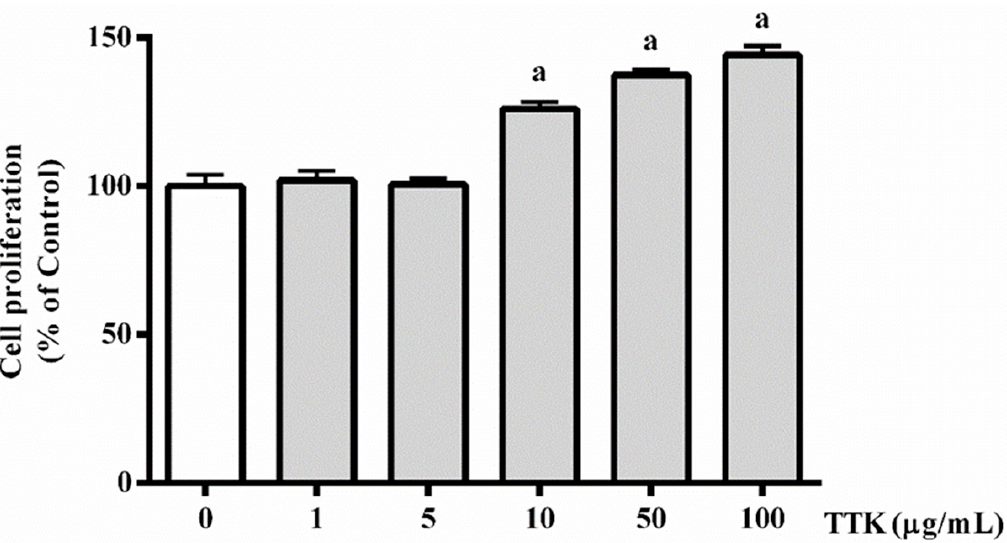
Figure 1. Effect of TTK on proliferation of HUVECs. Cells were plated to the 96-well plate and treated at the marked TTK concentration for 24 h. Cell growth rates were evaluated using WST assay. The experiments were repeated four times. The results are presented as the means ± SEM. a p < 0.001 vs. 0 (untreated cells).